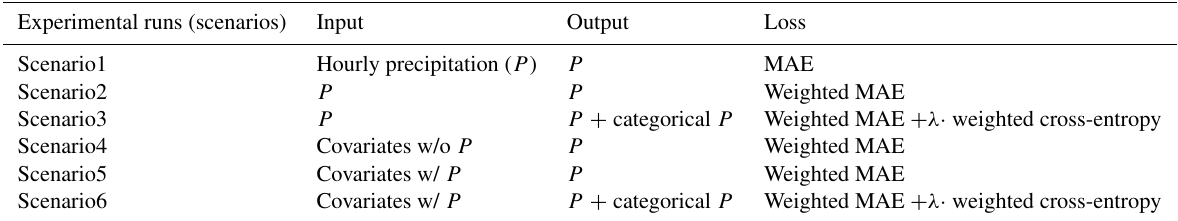
Table 1. Deep learning (DL) experimental design. Experimental runs